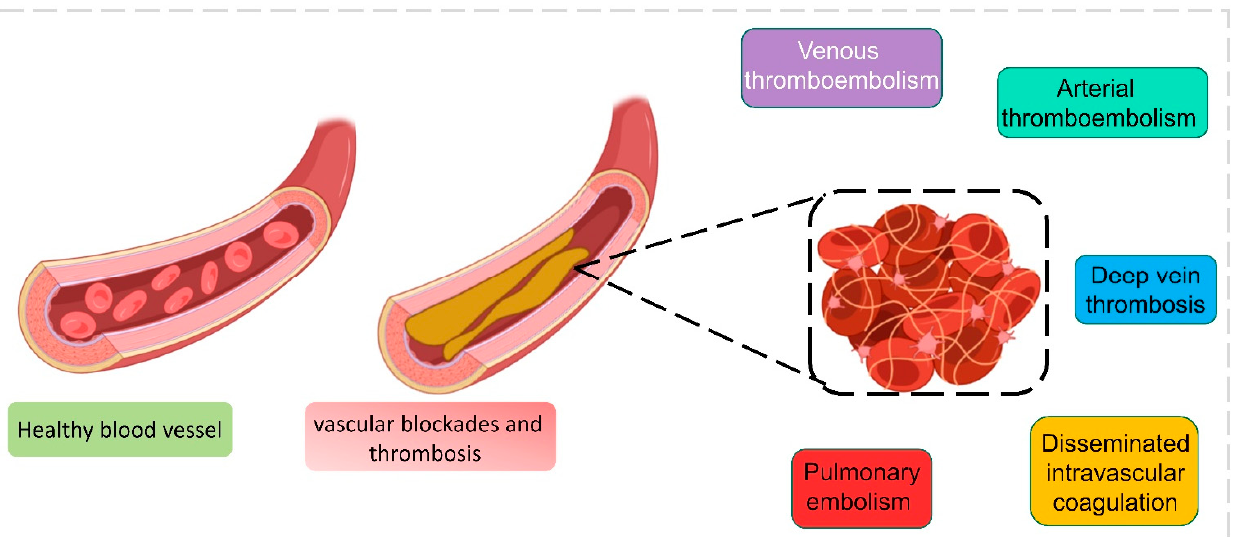
Figure 6. Deep learning-based imaging and detection of mucormycosis infection from images and data. Affected and standard images of rhinocerebral, ocular, cutaneous, pulmonary, and around 30 different parameters are used as input. Deep learning software is designed based on a human brain-like model, which consists of artificial neurons (nodes) organized next to each other in three different layers. (i) The input layer is provided with input data; (ii) the hidden layer executes different types of calculations, predictions, and operations; (iii) the output layer provides output data. Different knowledge from the health worker, such as diagnosis and medication; entered features such as sex, place, duration of diseases, COVID-19 symptoms, CAM symptoms; and numerical features such as age can be used by the deep learning model. Image classification, detection, and segmentation are the most common applications of deep learning model. Image classification determines whether an image is infected or not. Segmentation is a partition analysis to find infected and uninfected images.